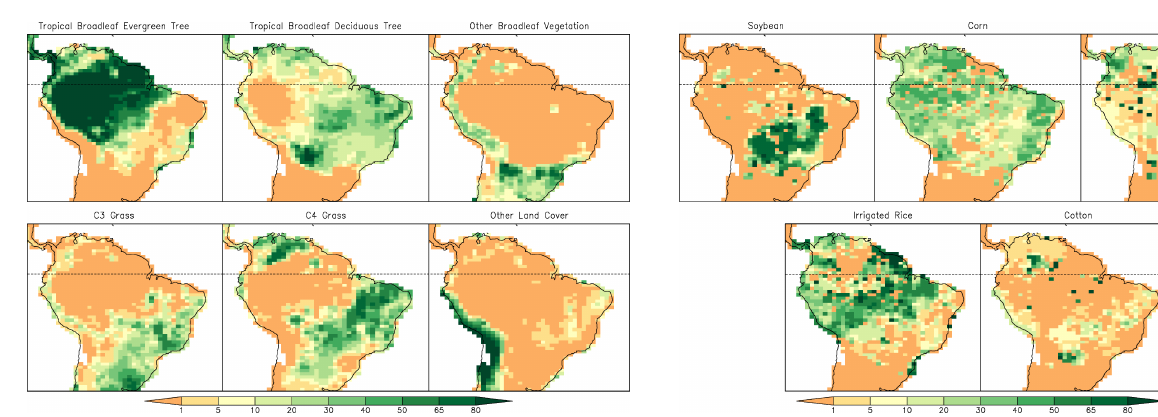
Figure 1. Distributions of the indicated plant functional types (PFTs) in the control simulation as a percentage of each grid box. “Other vegetation” includes C3 alpine grasses and bare soil.